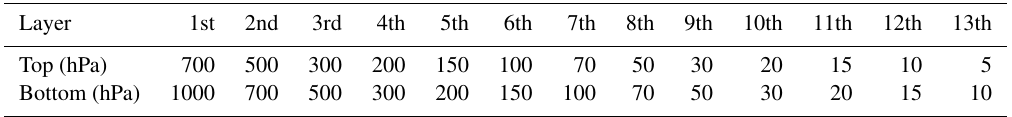
Table 4. Pressure range for an allocation of RS-11G and RS92 measurements. The differences between RS-11G and RS92